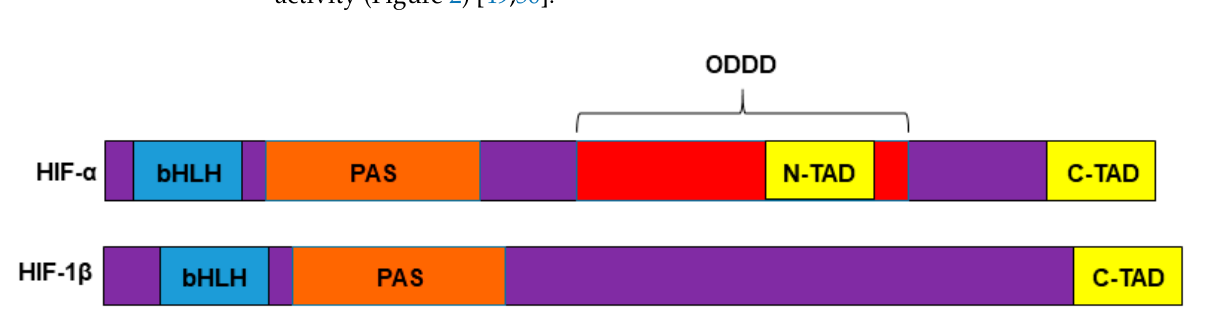
Figure 1. HIF protein domain structures. HIF-1 α , HIF-2 α , and HIF-1 β subunits contain a bHLH domain (blue box), a PAS domain (orange box) and a C-TAD domain (yellow box). In addition, HIF-1 α and HIF-2 α subunits contain an ODDD (red box) and N-TAD (yellow box) domains. Different variants of the HIF-3 α subunit containing diverse deletions of the domains shown in the figure have been shown to exist.